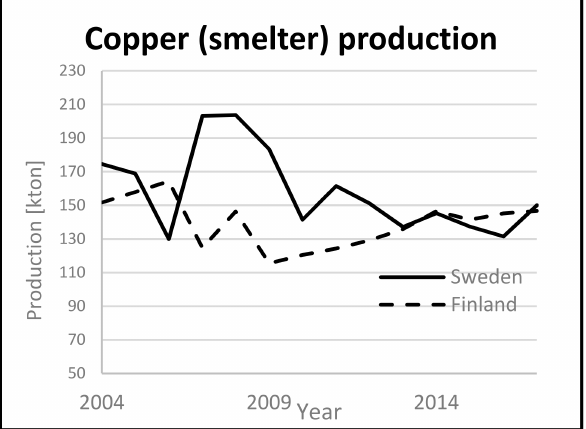
Figure 7. Copper production in Sweden and Finland between the years 2004–2017, in